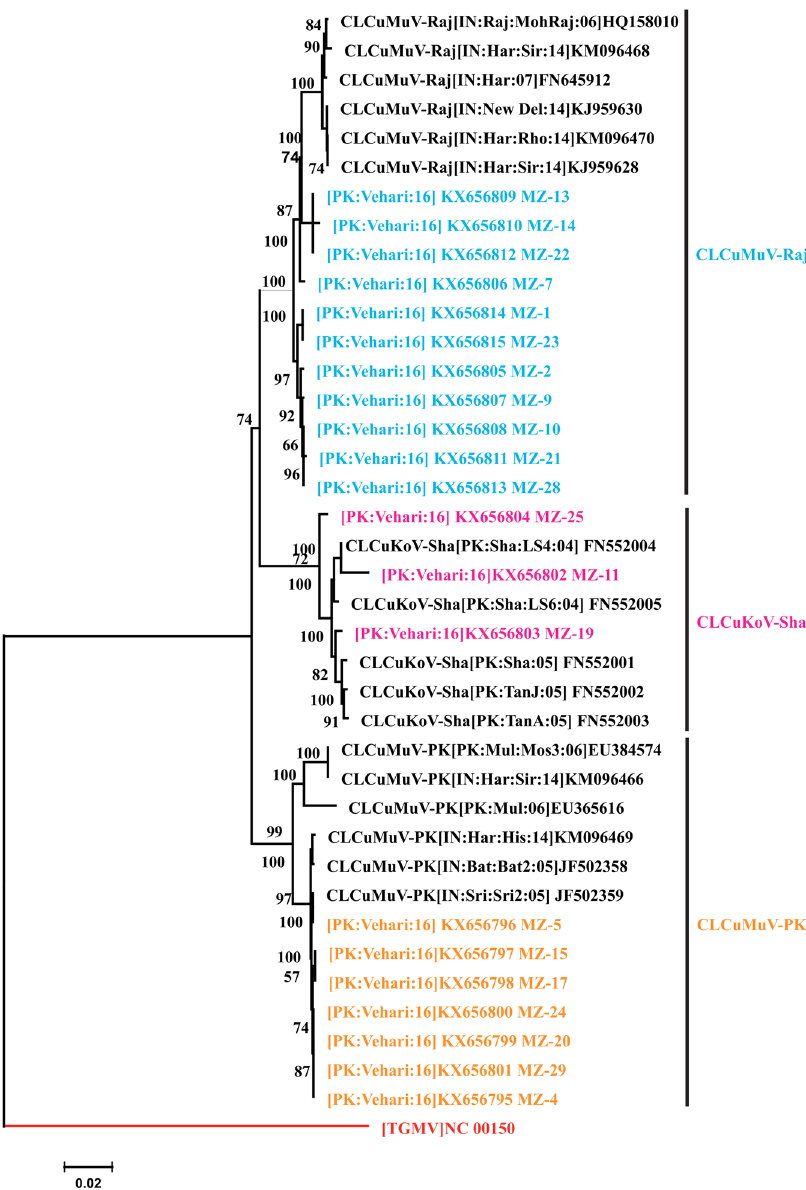
Figure 3. Phylogenetic tree of monopartite begomoviruses and DNA-A component. Cotton leaf curl Multan virus -Rajasthan (CLCuMuV-Raj) is colored sky blue, and Cotton leaf curl Kokhran virus -Shadadpur (CLCuKoV- Sha) is colored magenta and Cotton leaf curl Multan virus -Pakistan (CLCuMuV-PK) is colored orange. The tree arbitrarily rooted on Tomato golden mosaic virus (ToMoV) was taken as outgroup is colored red. The tree was generated with 1000 bootstrap value represented along each